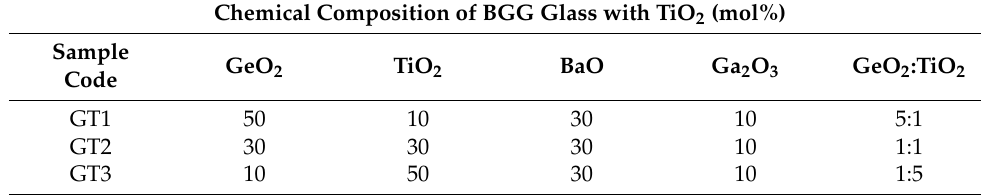
Table 1. Nominal composition (mol%) and GeO 2 /TiO 2 ratio of glass samples.